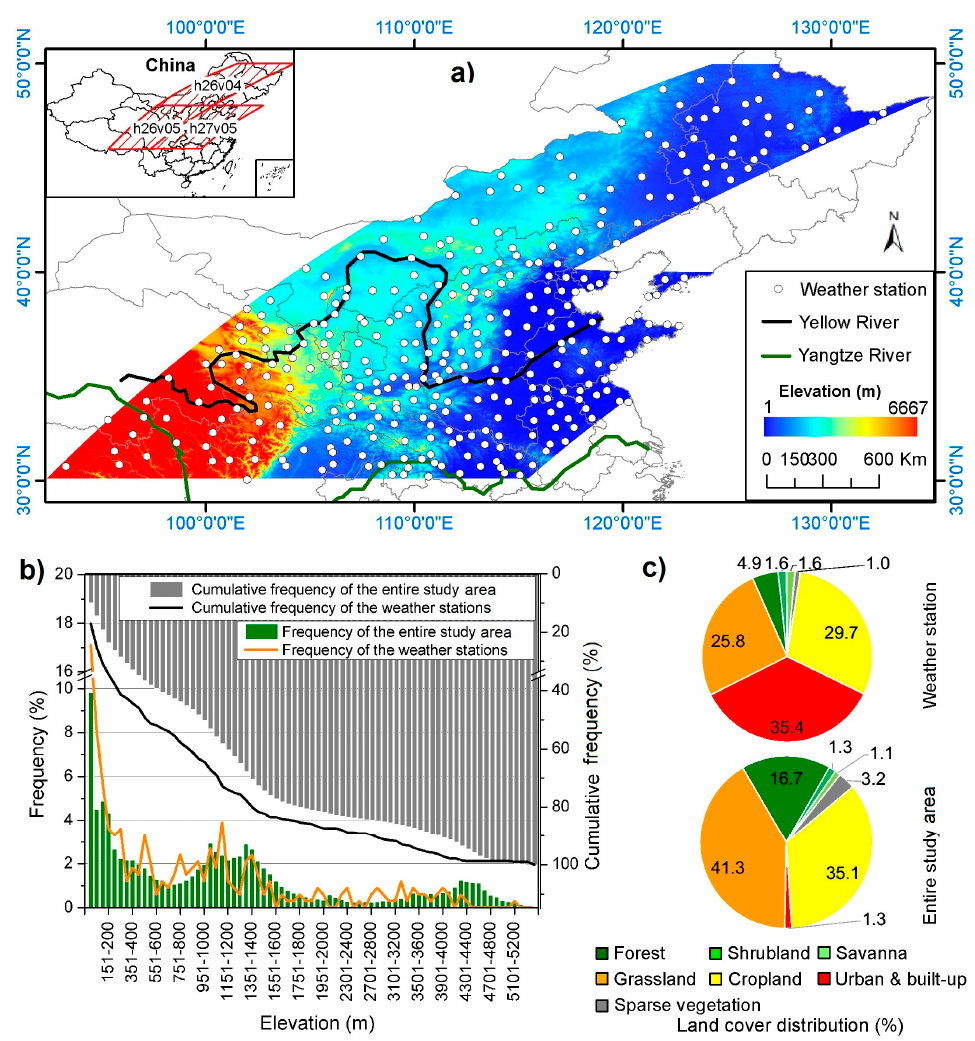
Figure 1. General view of the study area and weather stations: ( a ) spatial view; ( b ) statistics of elevation; ( c ) statistics of land cover. The elevation and land cover data were obtained from GTOPO30 digital elevation model (DEM) and yearly MODIS land cover product (MCD13Q1) in 2012, respectively.